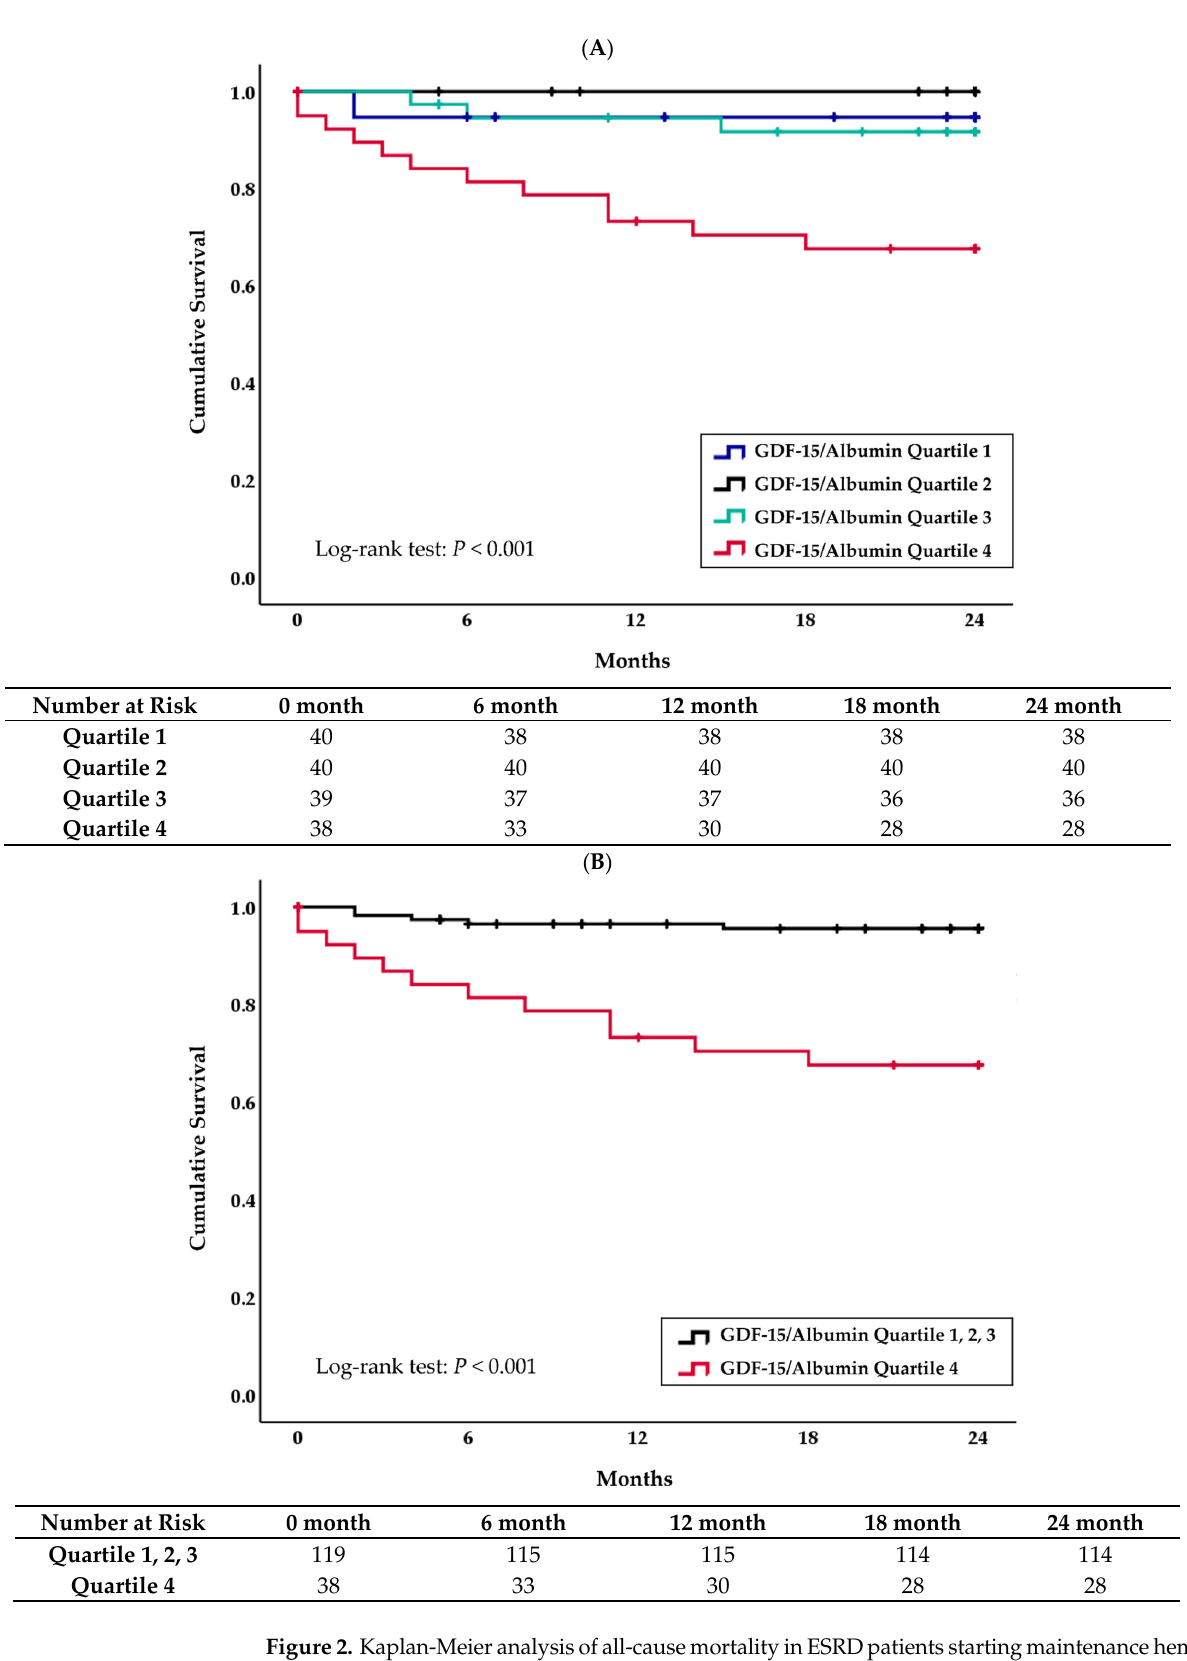
Figure 2. Kaplan-Meier analysis of all-cause mortality in ESRD patients starting maintenance hemodial- ysis according to: ( A ) each GDF-15/albumin quartile and ( B ) highest GDF-15/albumin